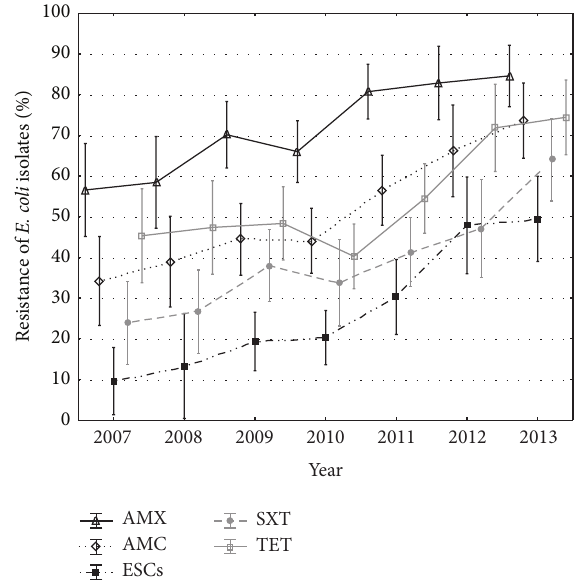
Figure 2: Increase in the frequency of resistance of canine